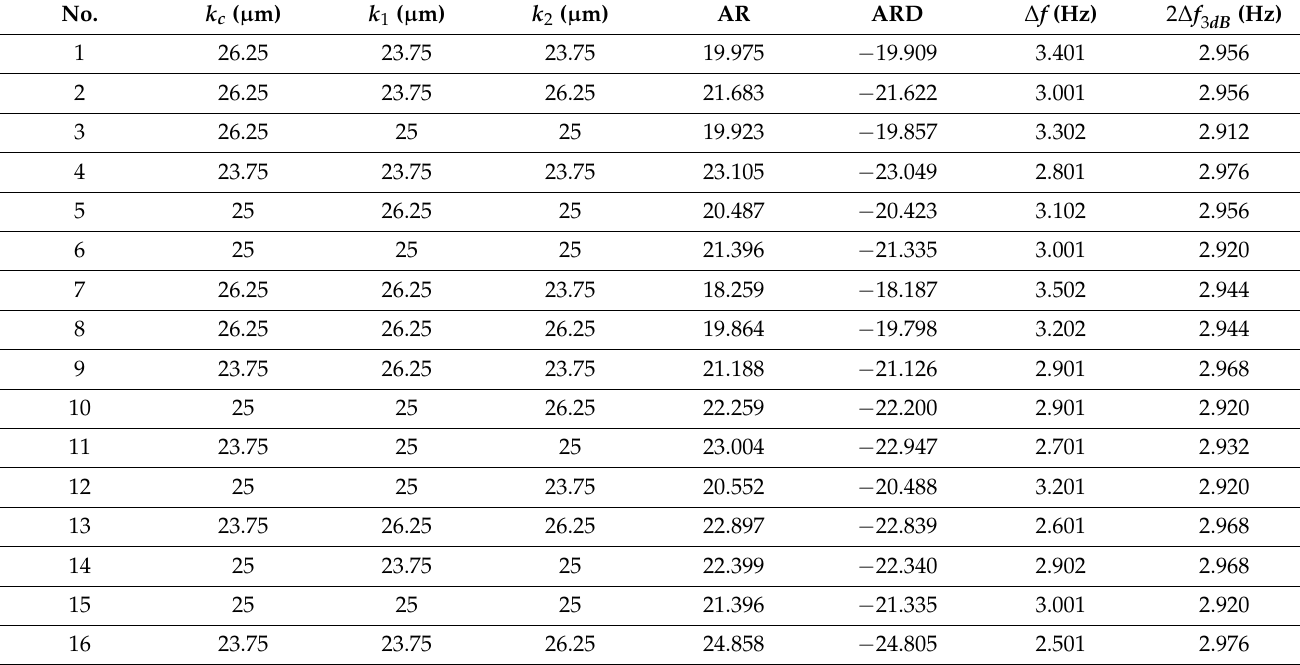
Table 4. The DOE based CCD design matrix for beam thickness of mechanical springs and corresponding output responses.